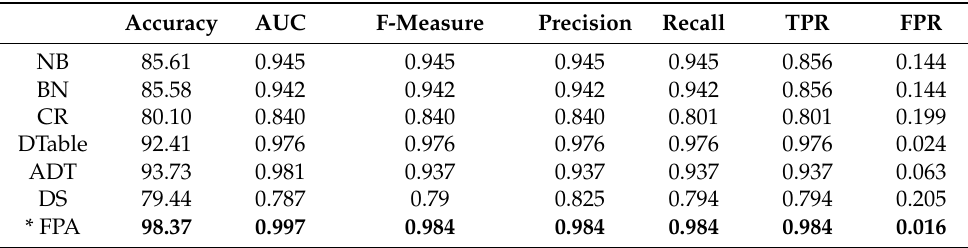
Table 9. Detection performances of FPA and baseline classifiers on the balanced (SMOTE) Drebin dataset.